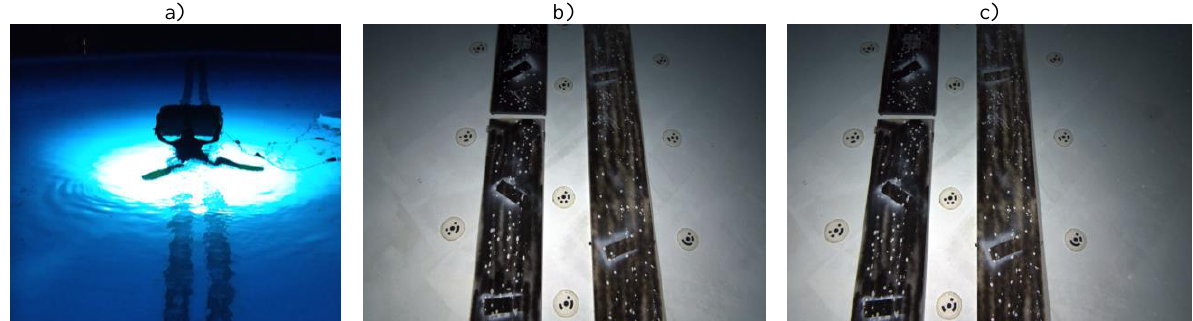
Figure 4. Diver manoeuvring the system during the acquisition of the image dataset used in the presented underwater experiments (a) and an example of the rectified image pairs depicting the pool floor with contrast plates and targets